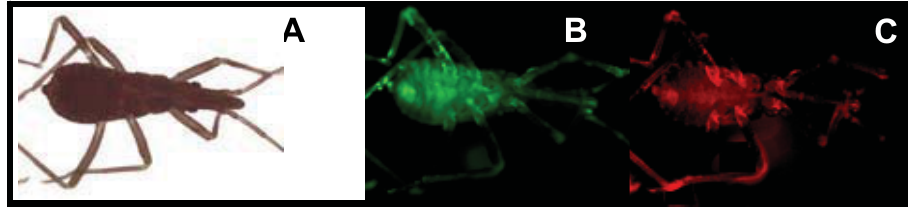
Fig. 2 – Maternal lipid localization in R. prolixus neonate nymphs. Purified lipophorin was double labeled with Texas Red PE and Bodipy FA injected into vitellogenic females; typically four days after injection, eggs were laid. They were kept at 28 ◦ C until hatching. Nymphs were immediately collected and kept on ice. Fluorescence associated with newborn nymph was analyzed by fluorescent microscopy. (A) Phase-contrast image. (B) Localization of Bodipy FA in newborn kissing-bug nymph. (C) Localization of Texas Red PE in newborn kissing-bug